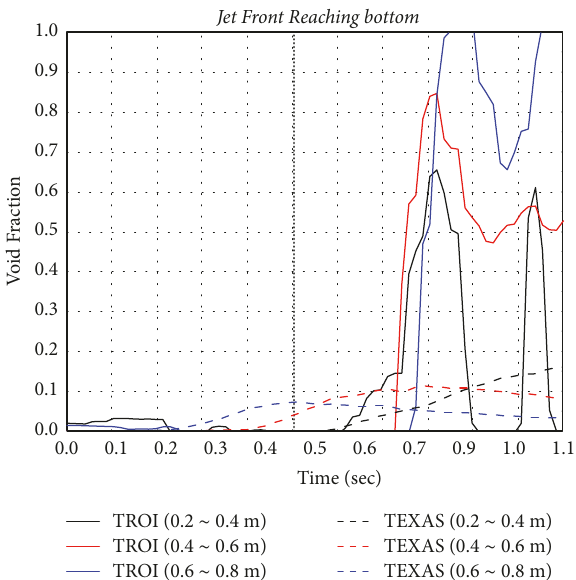
Figure 9: Velocities of melt front in experiments and simulations.